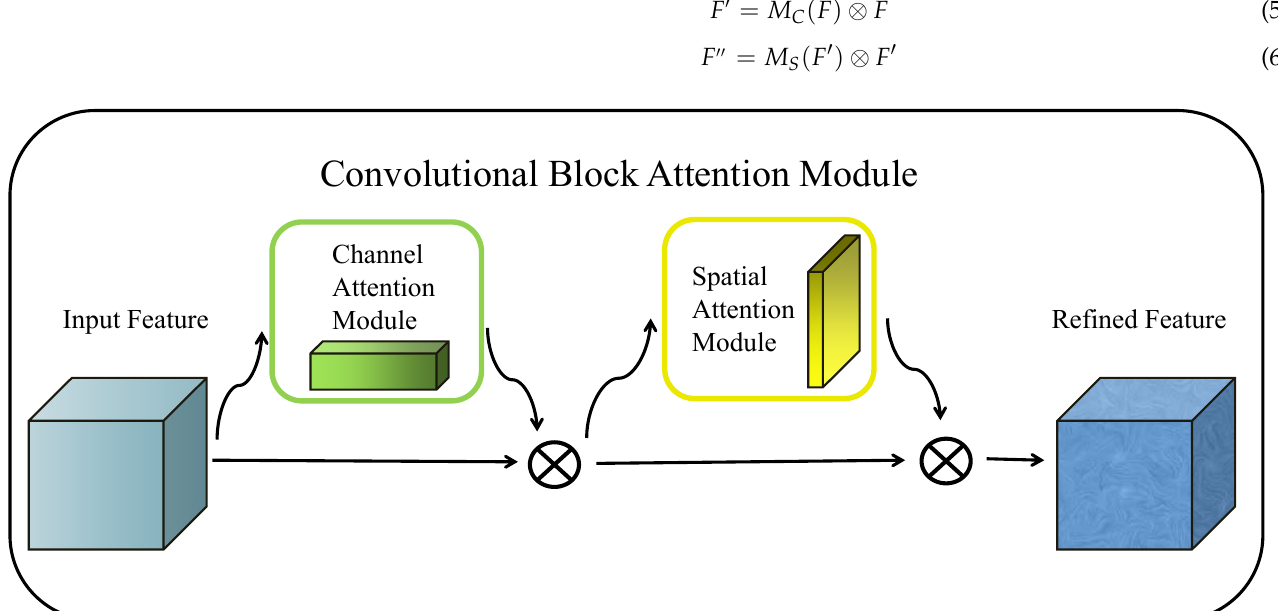
Figure 2. The structure of the CBAM.